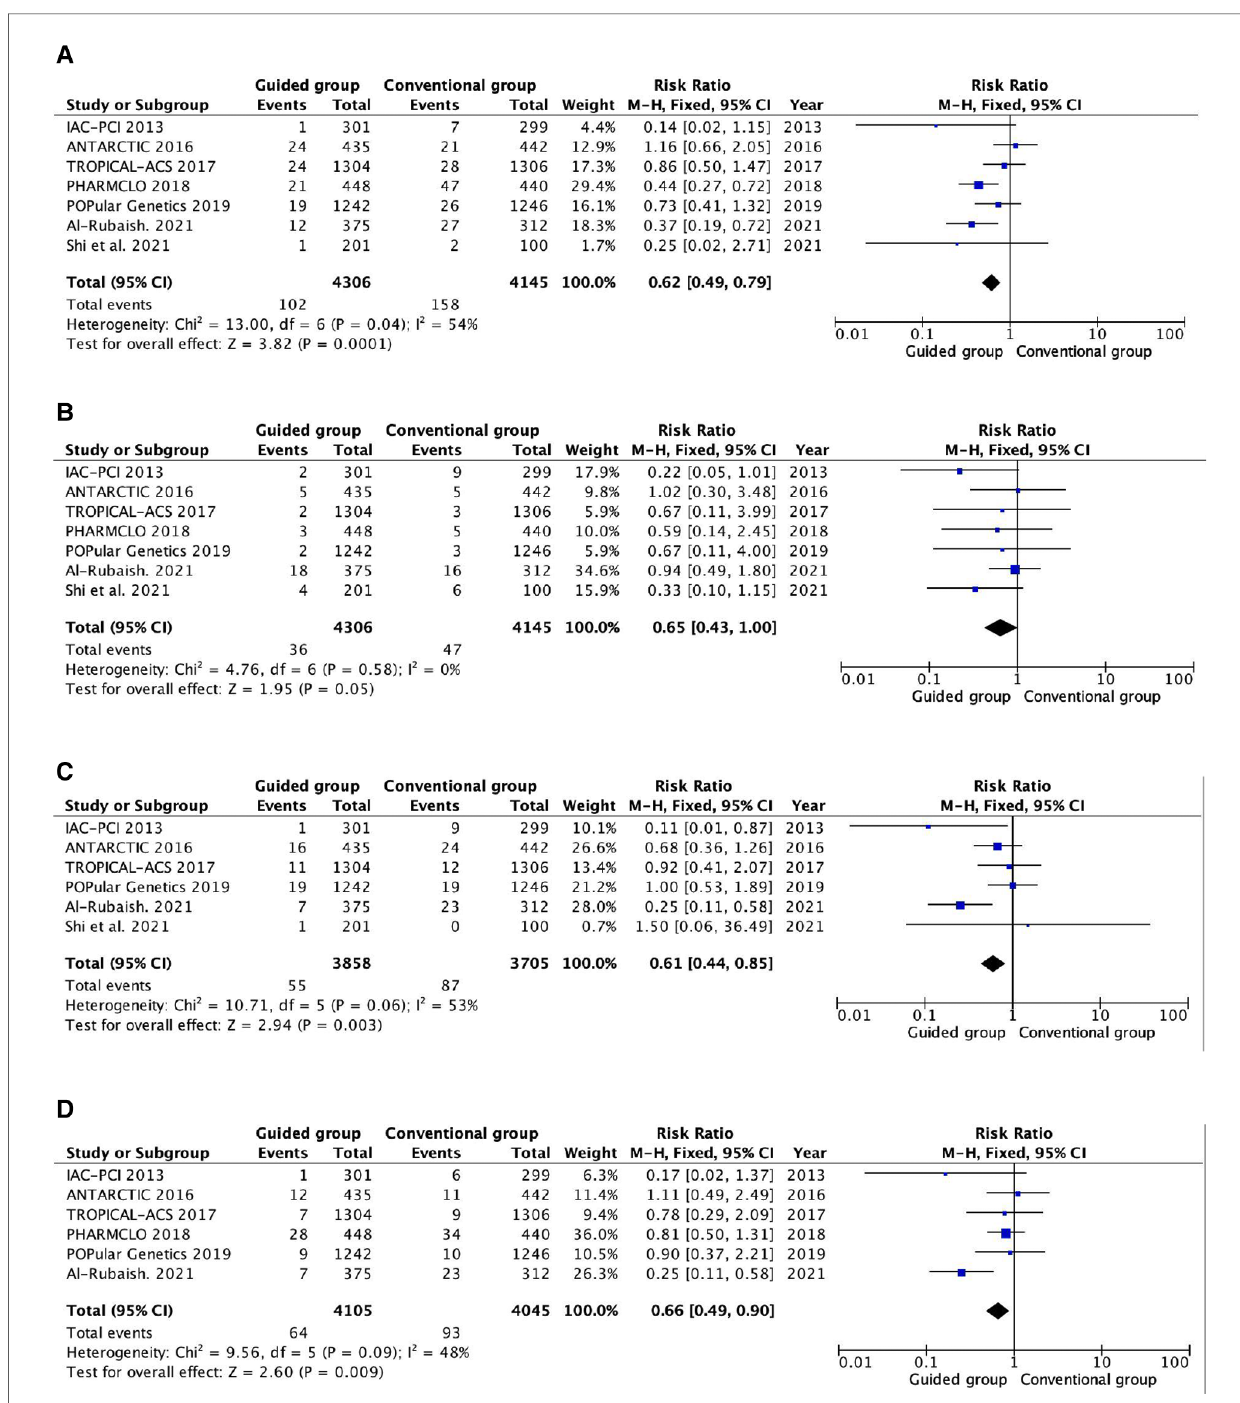
FIGURE 3 Pooled analyses of guided vs. standard antiplatelet therapy for the ef fi cacy outcomes. ( A ) Myocardial infarction; ( B ) stent thrombosis; ( C ) all-cause death; ( D ) cardiovascular